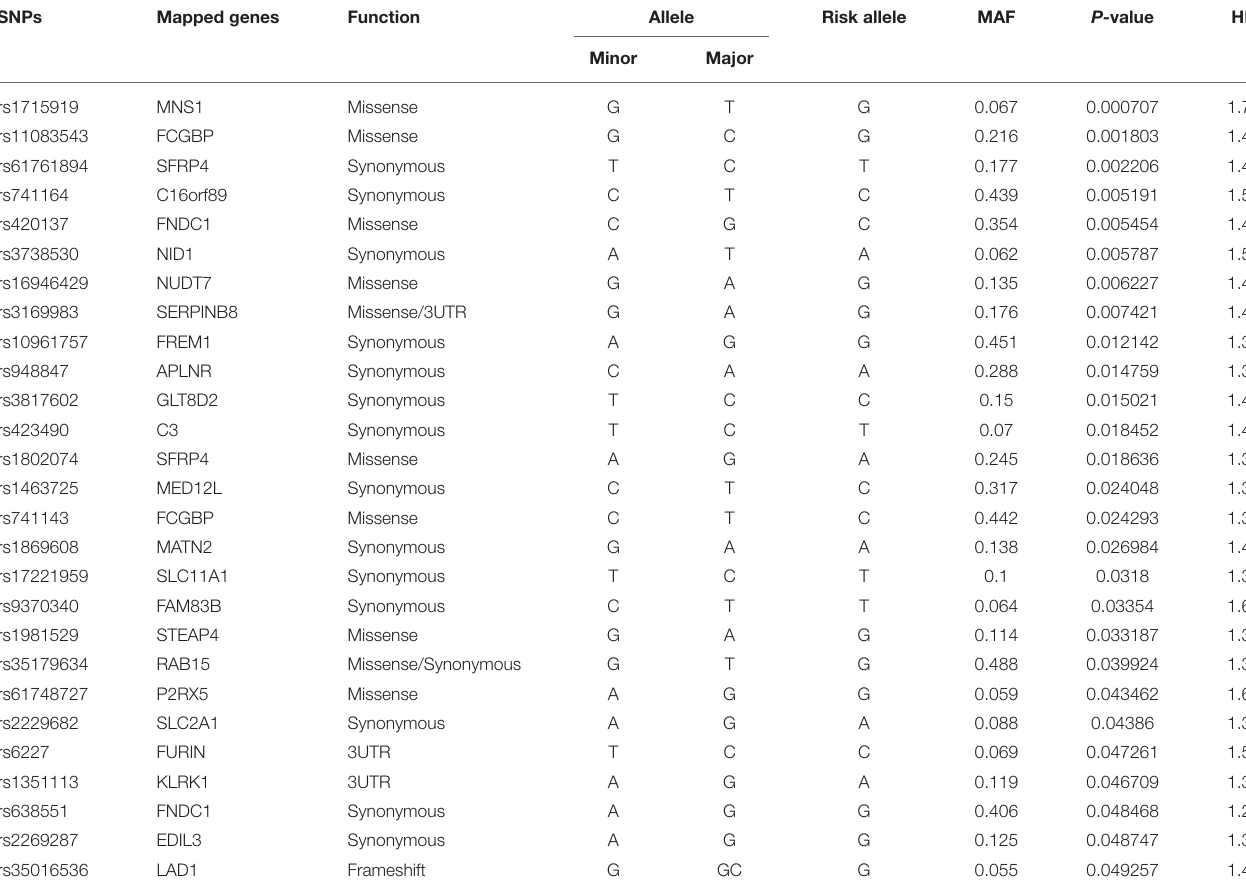
TABLE 2 | Statistically significant variants using Cox proportional hazard analysis in dominant model.